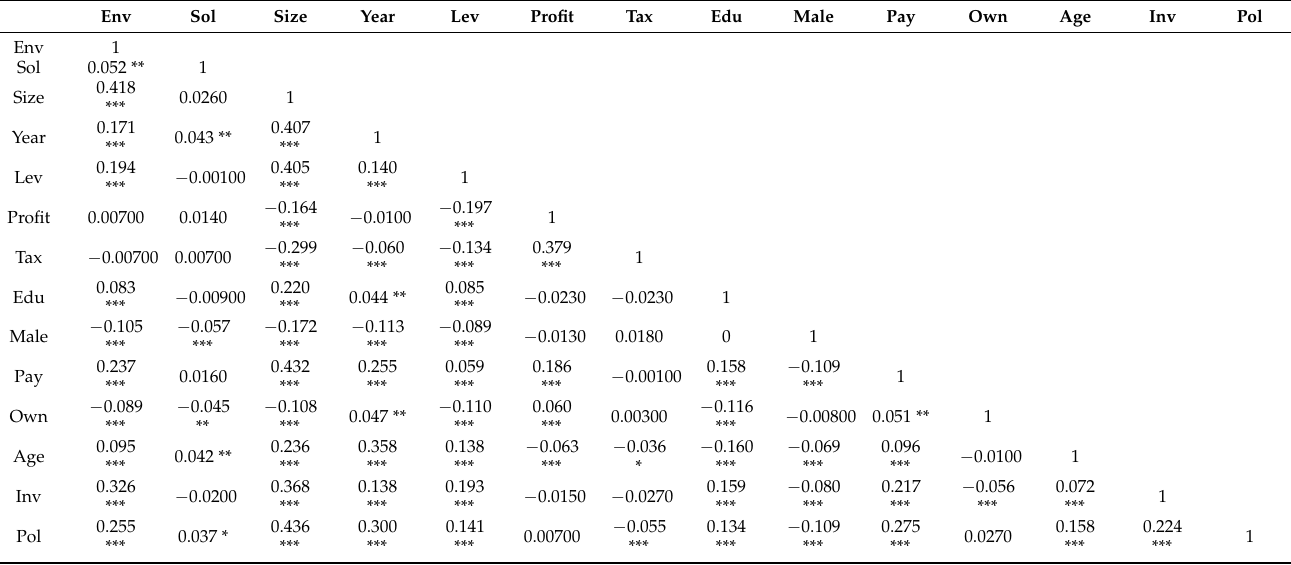
Table A2. Pearson correlation matrix of the dependent variable Env